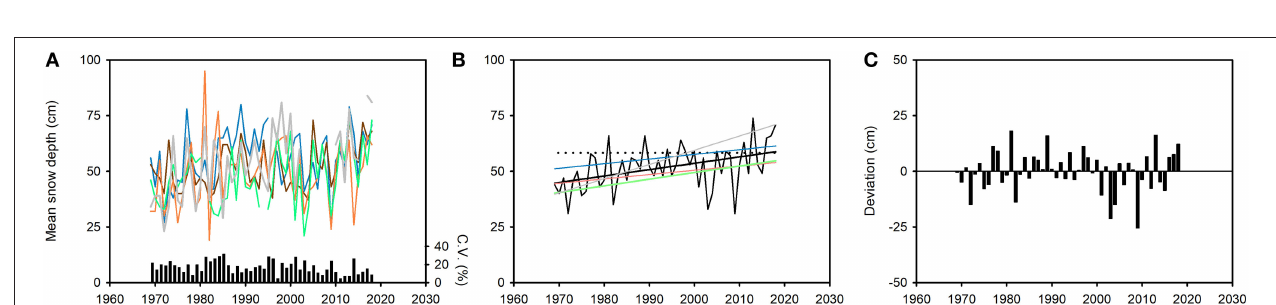
FIGURE 15 | Average depth of snow in March (the snowiest month) on the reindeer winter pasture area of Finnmarksvidda ( Figure 7 ), 1969–2018. Data from five weather stations: Cuovddatmohkki, Karasjok, Kautokeino, Sihccajavri and Skogfoss ( Figure 7 ). (A) Annual mean values at each station (cm) and annual coefficient of variation (C.V.) in mean depth across all stations (%). (B) Trends in snow depth from linear regression models. The model for the combined dataset (black curve) is Average depth (cm) year = [(0.288 · year) – 522.45], r 2 = 0.18, p < 0.01(solid black line). The dotted black line shows how the regression estimate for 2018 (58.8cm) was exceeded by the observed annual average only six times prior to 2011. Regression lines (but not data) for each station (excepting the regression line for Sihccajarvi which is indistinguishable from the line for the combined data set). (C) Annual deviations from the regression model for the combined dataset (cm). For color codes, see Figure 9 ; gray: Skogfoss.